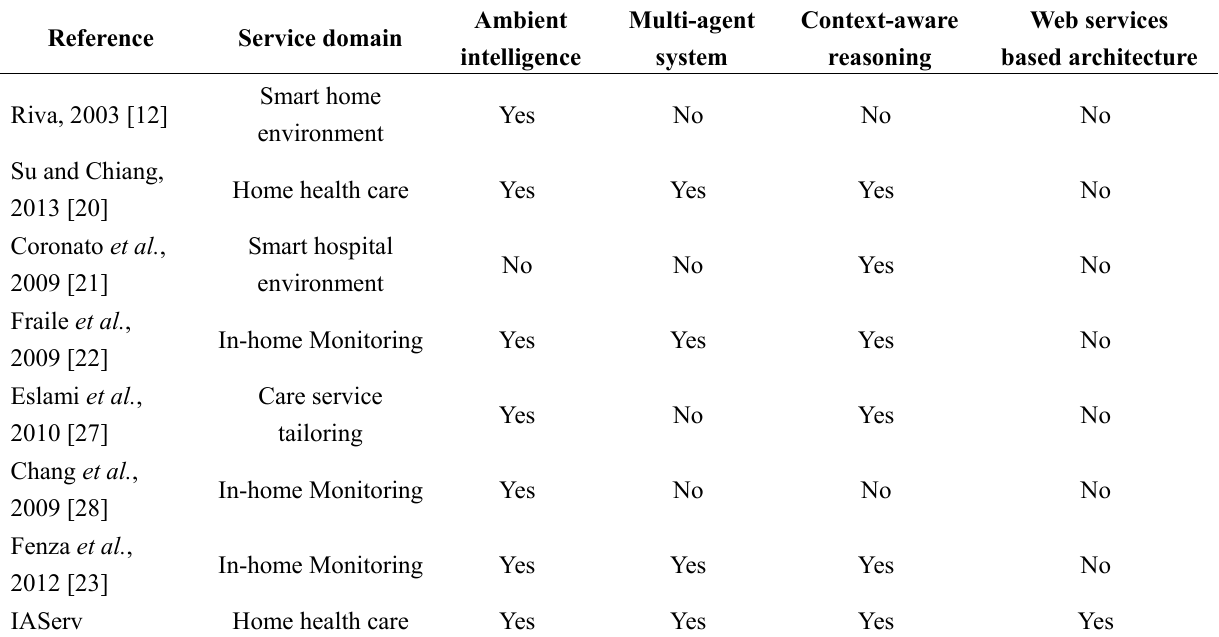
Table 5. Comparison of IAServ and other proposed